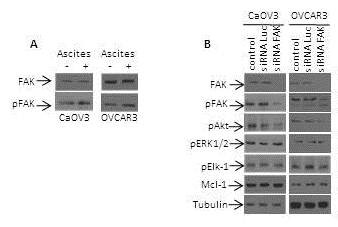
Ascites-induced ERK1/2 activation is independent from the activation of FAK. (A) Immunoblot analysis of expression and activation of FAK in both CaOV3 and OVCAR3 cells in the presence of ascites (OVC415). (B) Cells were transfected with vehicle (control), control luciferase siRNA (siRNA Luc) or FAK siRNA (siRNA FAK) and 24 h later cells were stimulated with OVC415 ascites for 1 h. Lysates were then obtained and analyzed by immunoblot for total and phospho-FAK (Tyr397), phospho-Akt (Ser473), phospho-ERK1/2, phospho-Elk-1 and Mcl-1. Representative data from three independent experiments.